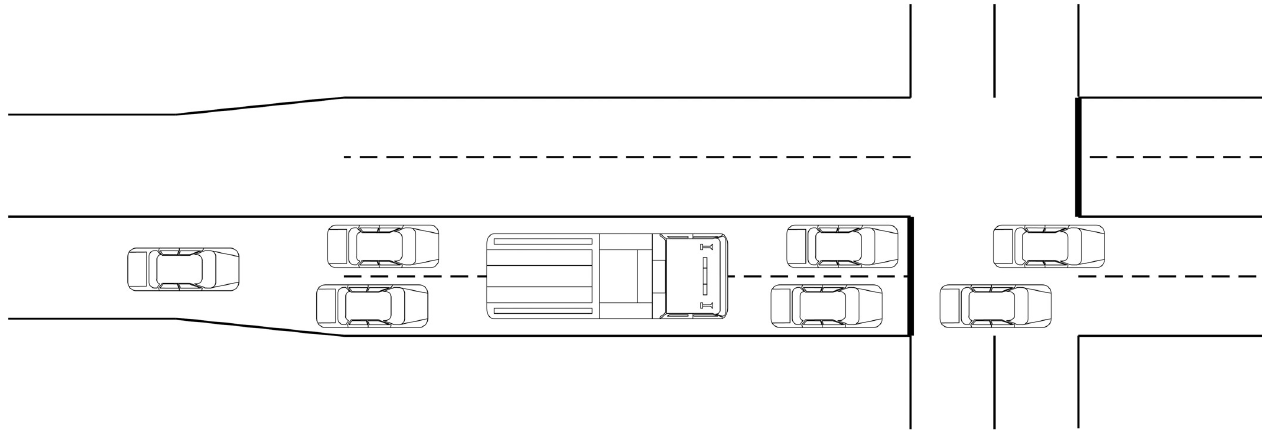
Fig 1. Layout design of